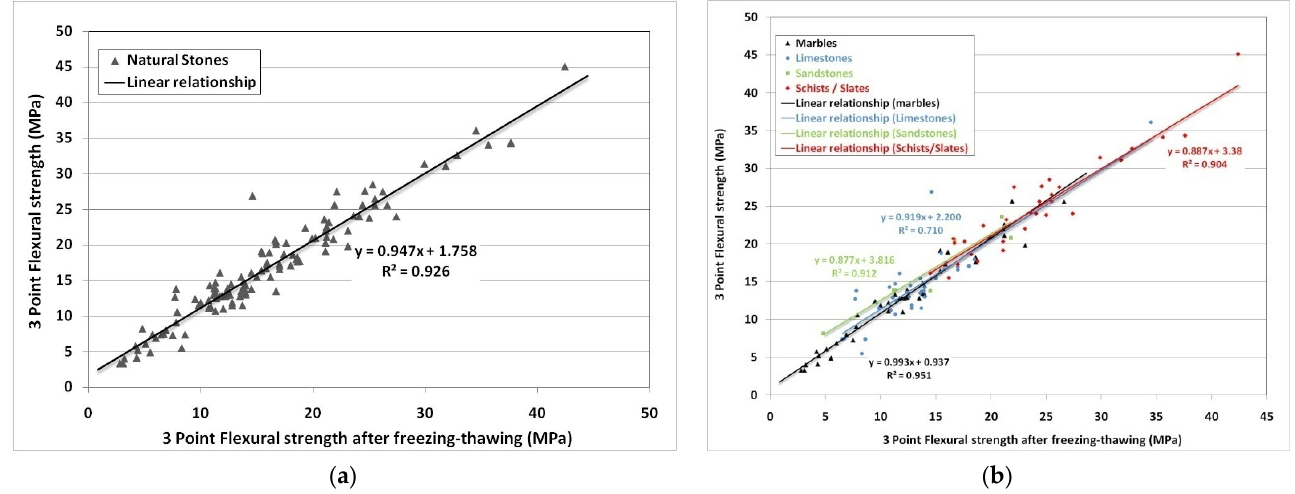
Figure 3. ( a ) Overall correlation between FS 3 and FTFS 3 . ( b ) Correlation equations between FS 3 without freezing–thawing and FS 3 after freeze–thaw.